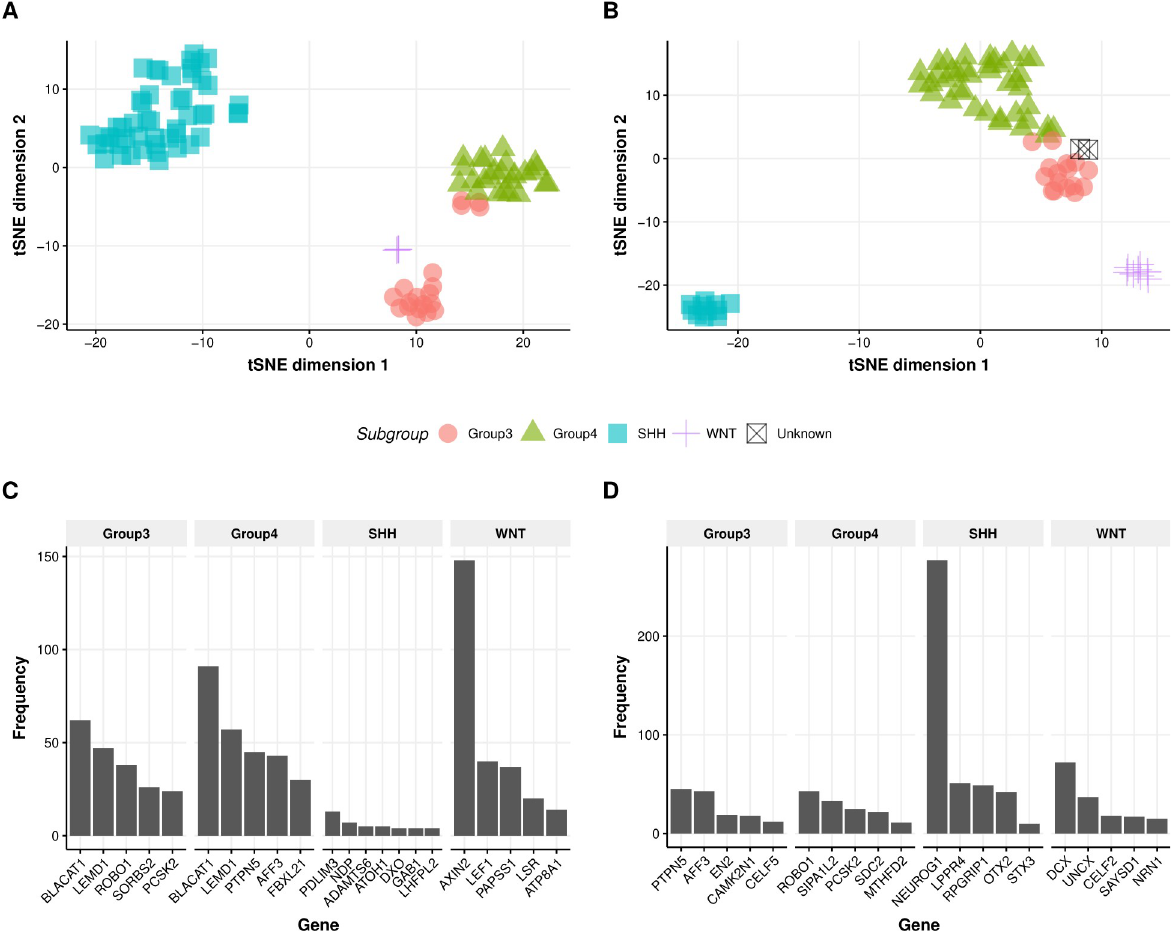
Fig 3. Selected GERs are able to distinguish between the four Medulloblastoma subtypes. A. t-SNE Plot of 1,795 selected GERs across 97 primary medulloblastoma ( RNA-seq: EGAD00001001899). B. t-SNE Plot of 1,795 selected GERs across 76 primary medulloblastoma ( Microarray: GSE37418). C. Bar chart showing top 5 genes frequently occuring in numerator of GERs in each molecular subtype. D. Bar chart showing top 5 genes frequently occuring in denominator of GERs in each molecular subtype.